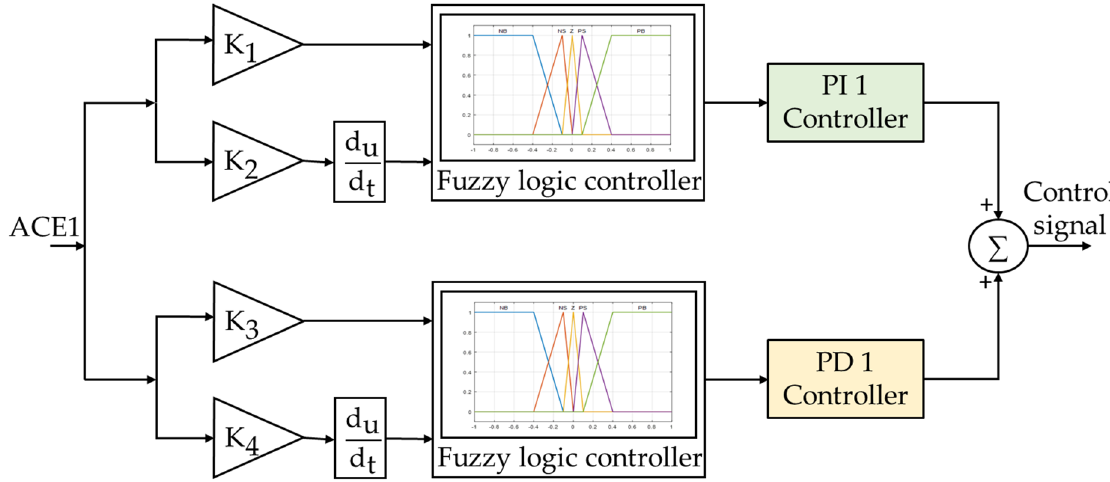
Figure 16. Block diagram of Fuzzy Cascade PI − PD controller configuration equipped in area one.